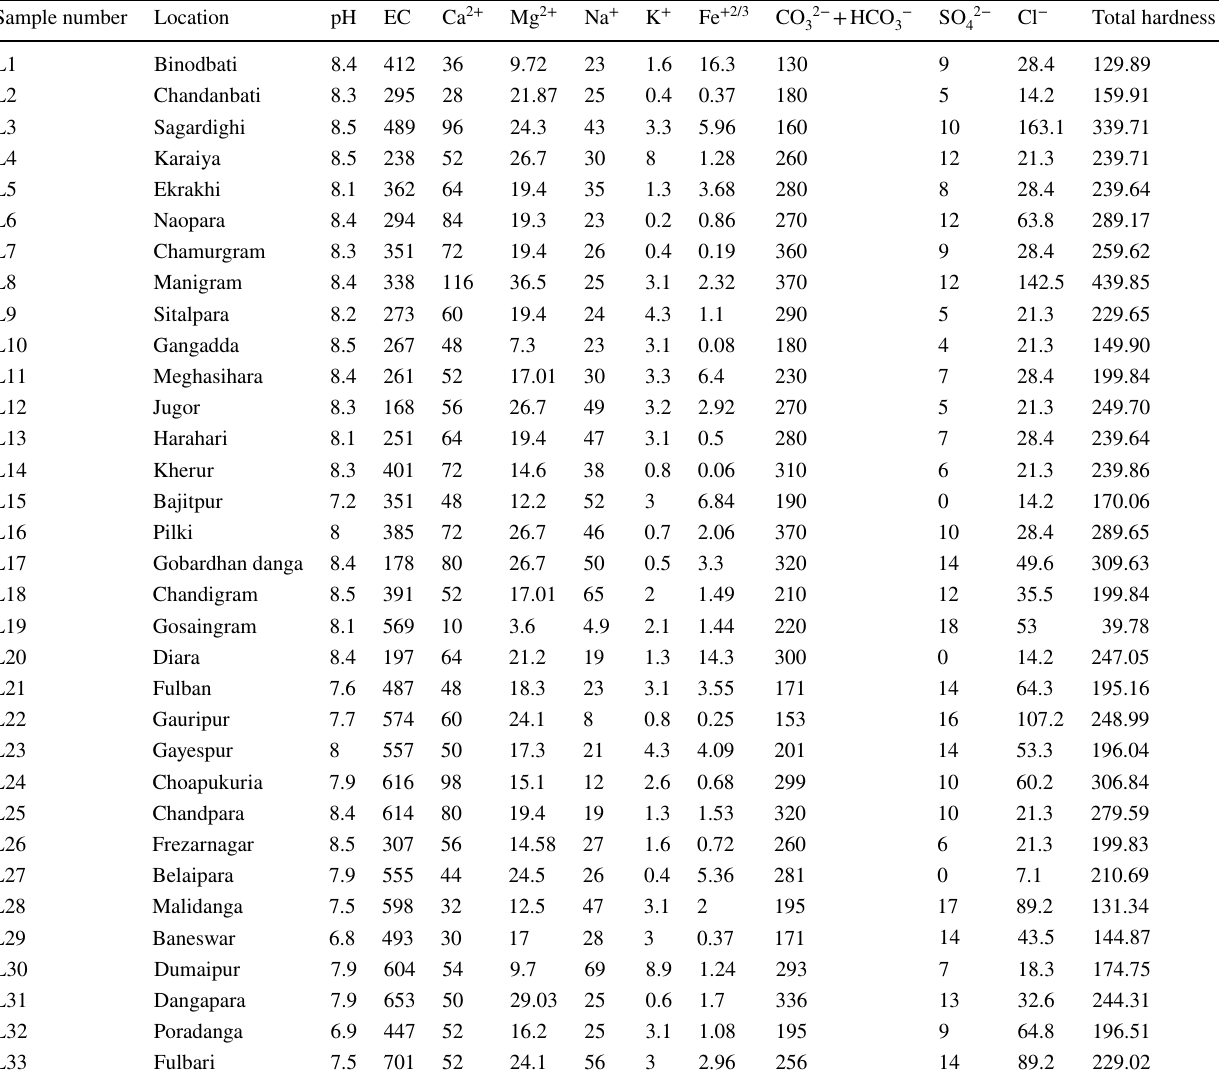
Table 1 Analytical data for the groundwater samples from the study area (EC in μS/cm, remaining mg/l, except pH) Sample number Location